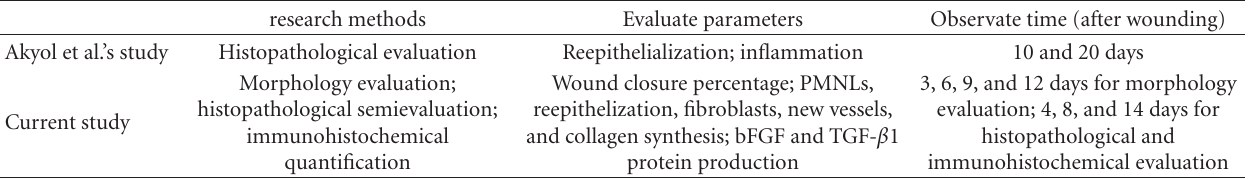
Table 4: The di ff erences of the evaluate parameters in two